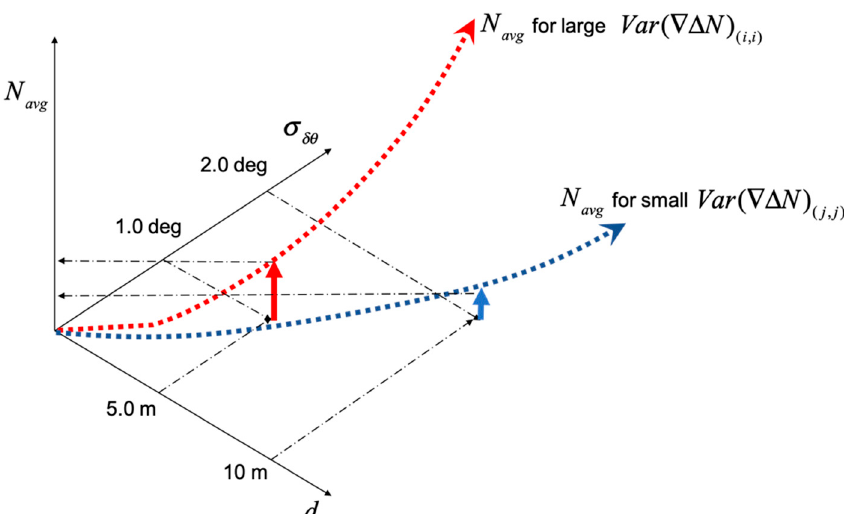
Figure 5. The figure describes the impact of d and σ on N avg from Tables 1 and 2. In general, N avg increases as d and σ increase. However, the higher d and σ do not always gurantee the larger N avg as shown above because Var ( ∇ ∆ N ) also takes into account the directions of the double difference line-of-sight vector and b 0 .